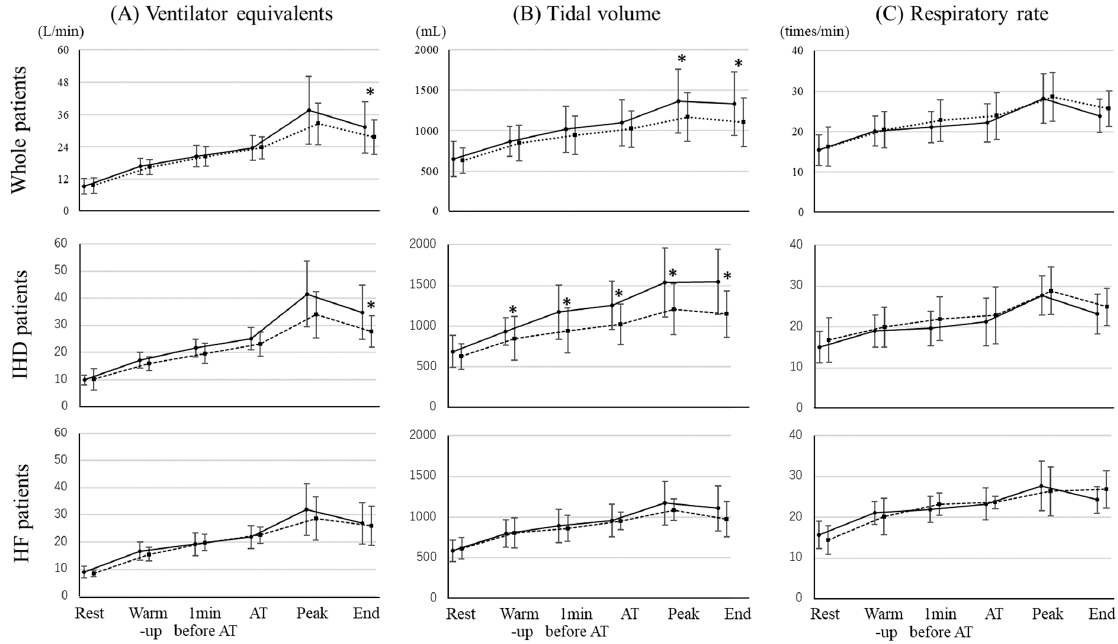
Figure 3. The differences of respiration activities in CPET between normal HADS group and high HADS group in whole patients, IHD patients, and HF patients. ( A ) Ventilator equivalents, ( B ) tidal volume, and ( C ) respiratory rate in whole, IHD, and HF patients are shown. A solid line and circle marker indicates the normal HADS group and a dotted line and square marker indicates the high HADS group. CPET: cardiopulmonary exercise test, IHD: ischemic heart disease, HF: heart failure, AT: anaerobic threshold. * p <